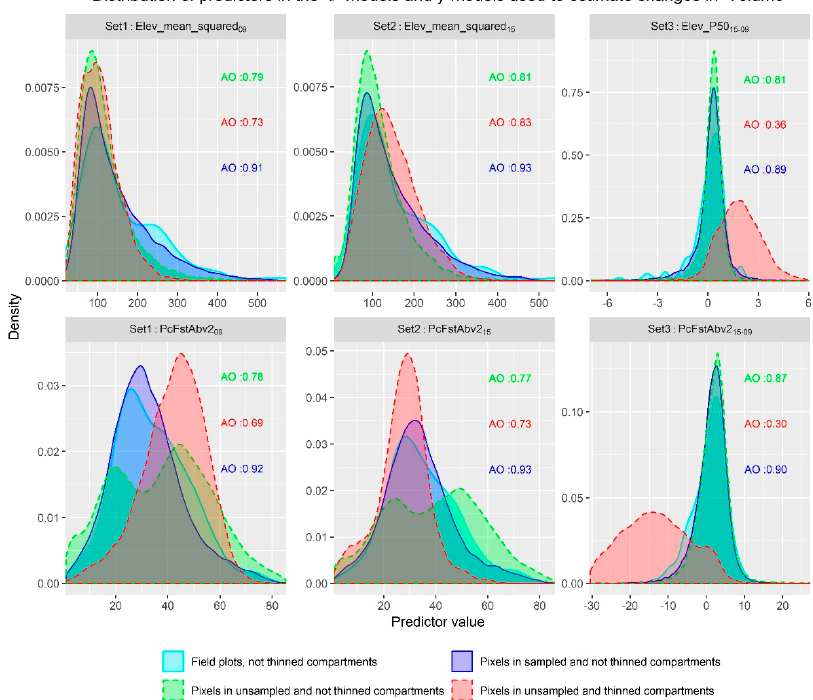
Figure 6. Comparison of density functions for the predictors in the models used to estimate changes in Volume using the δ -modeling method and y -modeling method in field plots (light blue), sampled and not thinned stands (dark blue), unsampled and not thinned stands (light blue) and unsampled and thinned stands (red). For each group the area of overlap, AO, with the density function for the field plots (green) is provided for each predictor.